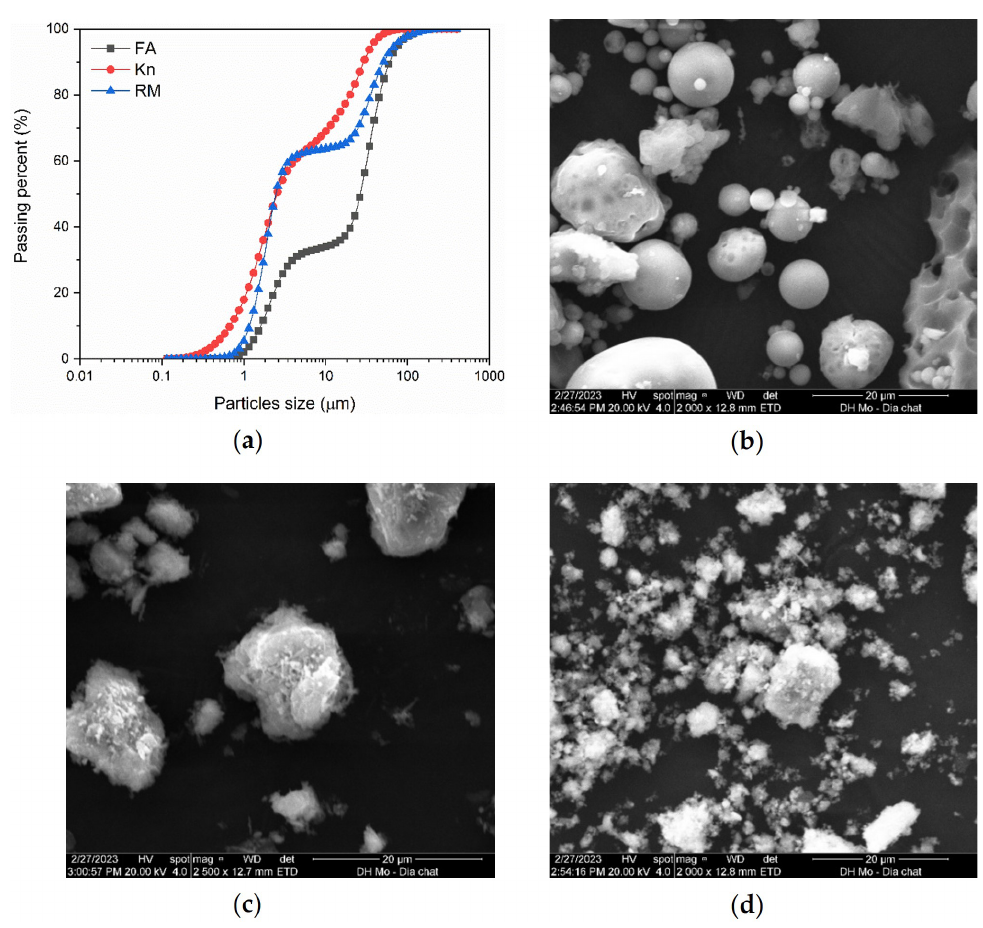
Figure 2. Particle size distribution of kaolin (Kn), fly ash (FA), and red mud (RM)—( a ) and SEM pictures of fly ash ( b ), kaolin ( c ), and red mud ( d ).